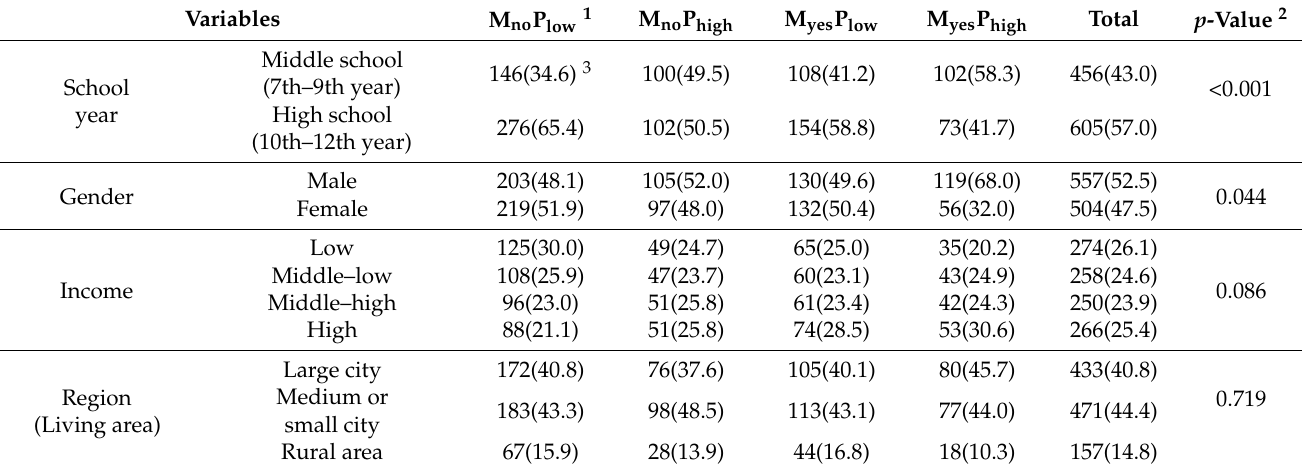
Table 1. Sociodemographic characteristics of the subjects.